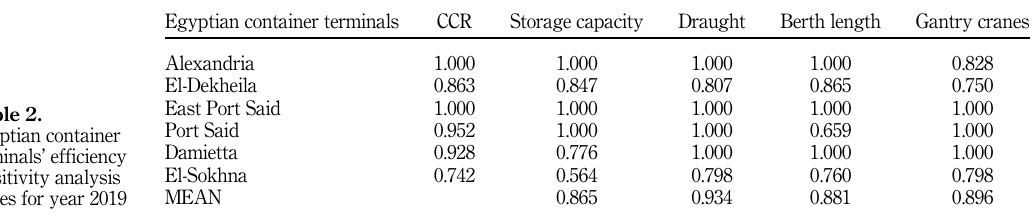
Table 2. Egyptian container terminals ’ efficiency sensitivity